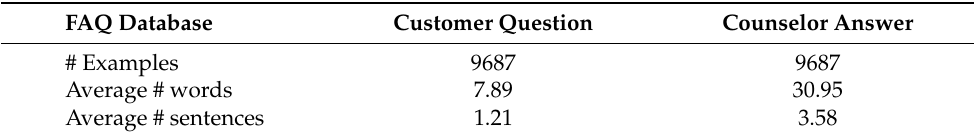
Table 2. Statistics for FAQ database . We construct the FAQ database to retrieve dialogue history of customers and counselors based on sentence textual